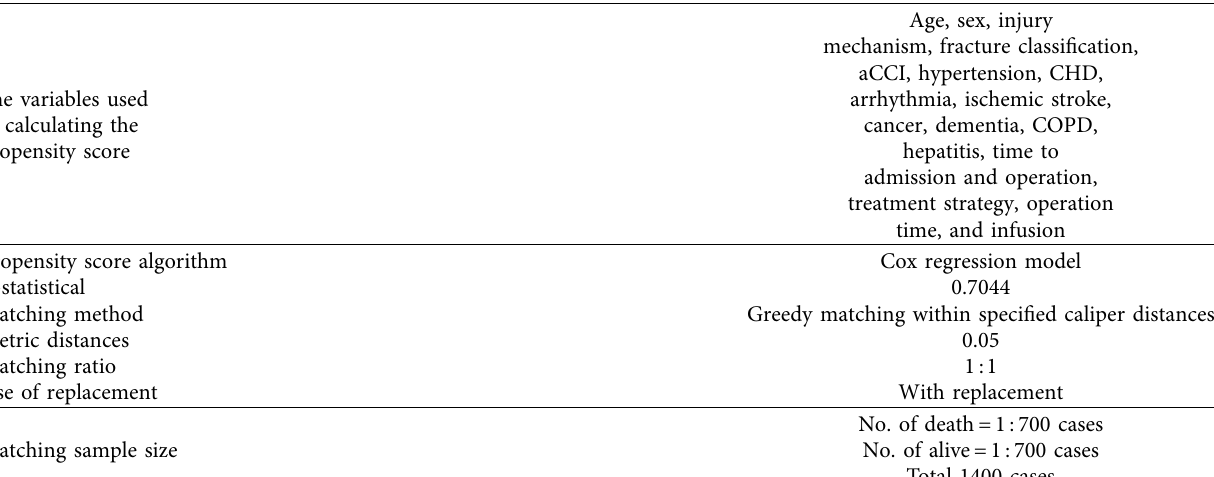
Table 5: Propensity score parameter list.